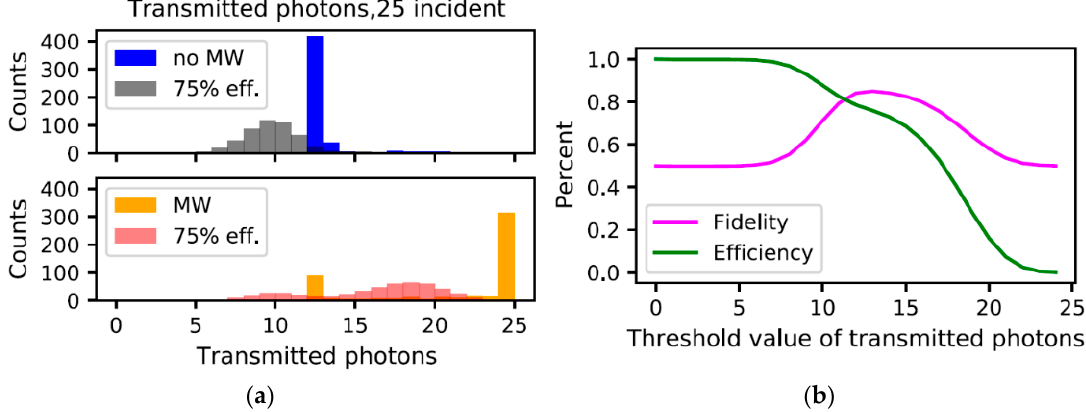
Figure 8. ( a ) Adjusted histograms, accounting for imperfect optical photon detector. The microwave parameters are g b /2 π = 10kHz and Q b = 10 6 . ( b ) Fidelity and microwave detection efficiency for the adjusted histograms.